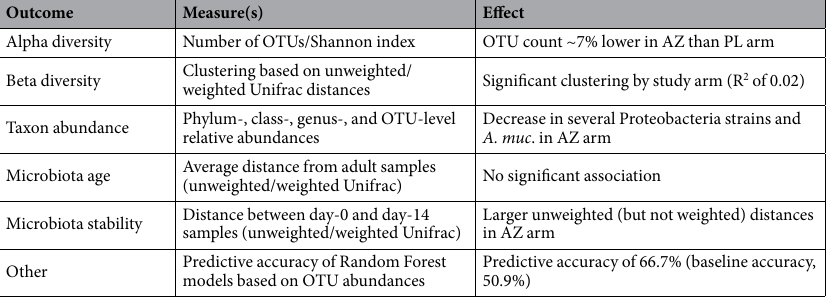
Table 1. Summary of associations between azithromycin treatment and microbiota composition at day 14. Abbreviations: A. muc ., Akkermansia muciniphila ; AZ, azithromycin; OTU, 97%-identity operational taxonomic unit; PL, placebo.